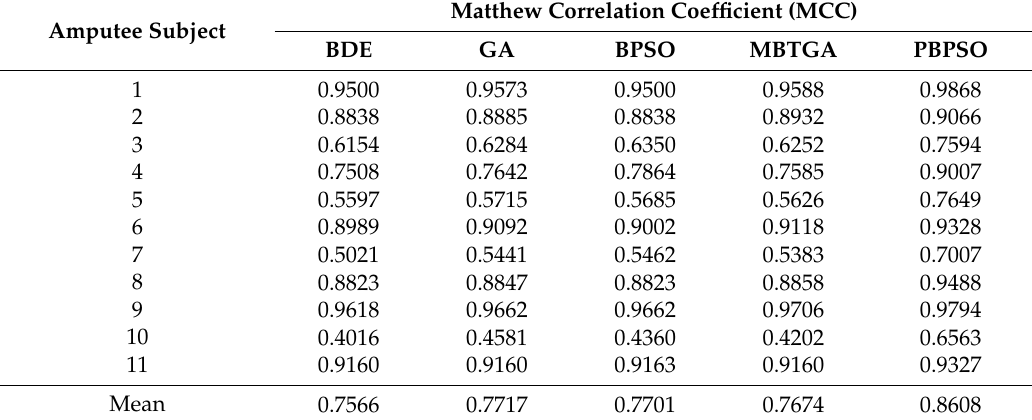
Table 3. Matthew correlation coefficient (MCC) results of five different feature selection methods for 11